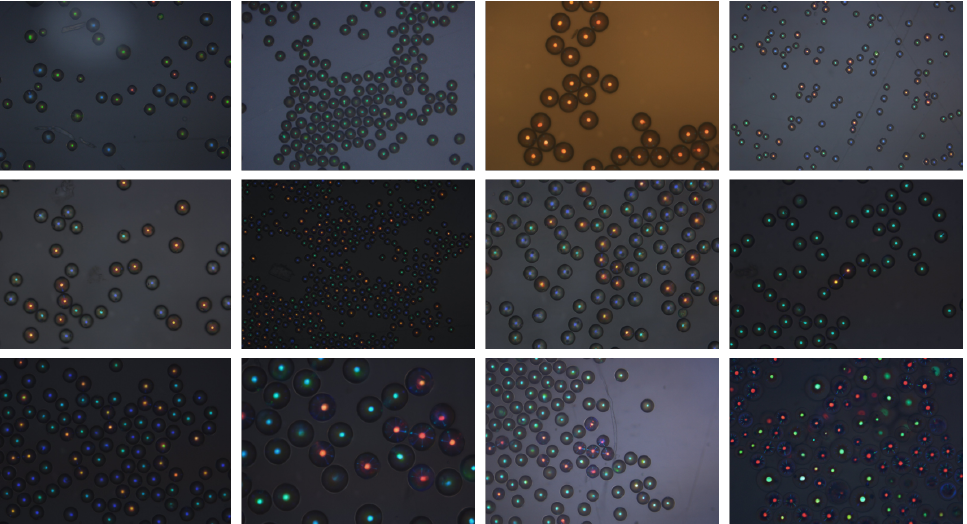
Figure 2. We observe great variability in both CSRs and backgrounds of the Laboratory Data set [6]. It is observed a circular reflection spot at the center of every CSR, these colored elements are present across all different responses. There are also other colored features in the patterns, with certain radial and azimuthal distributions with respect to the centers of each CSR, e.g., the image in column 4 row 3. Processing CSR images and extracting features from CSR IDs have been pioneered in Lenzini et al. [4] and Arenas et al. [6]. The first work compares histograms of images, a very basic strategy, to see whether the information hidden in the colored patterns is enough to discern among different arrays of CSRs. Results were preliminary with plenty of room for